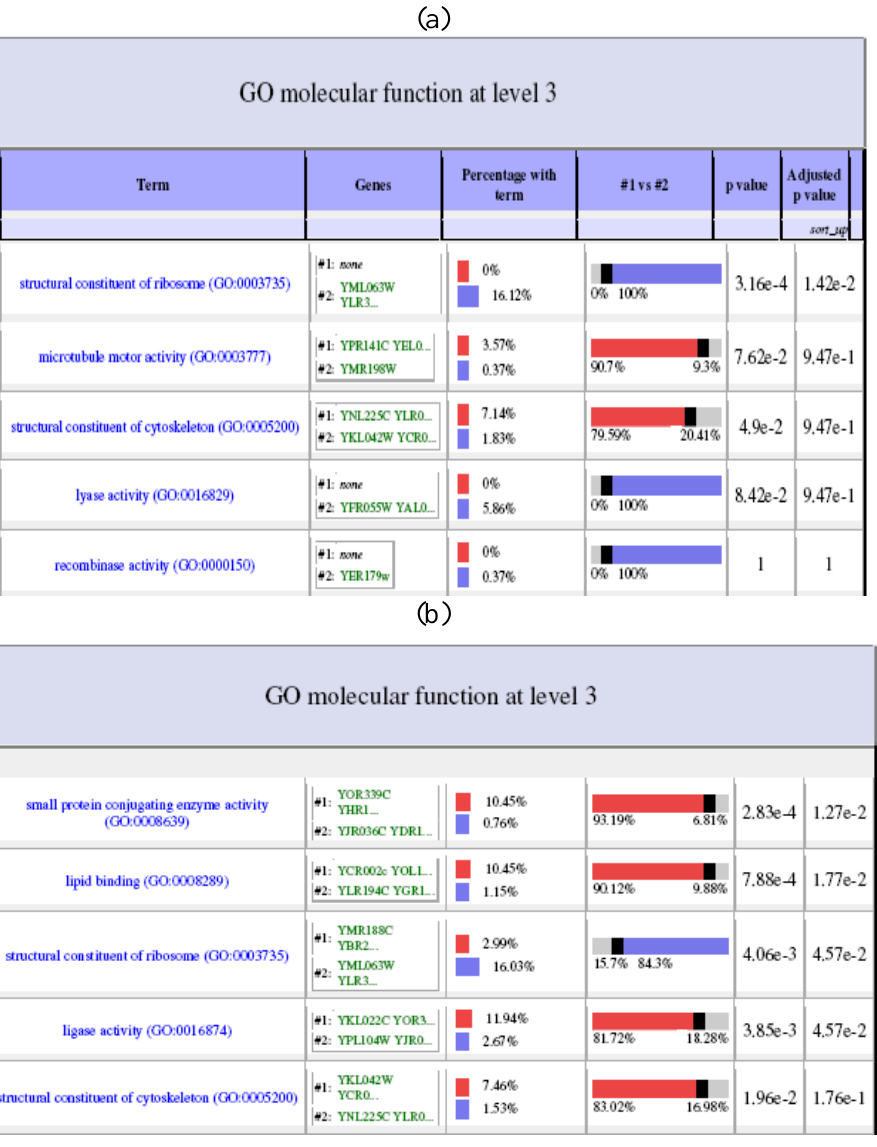
Figure 12. Part of FatiGO result for (a) cluster 6 and (b) cluster 2 of the best multi- objective clustering algorithm on yeast sporulation